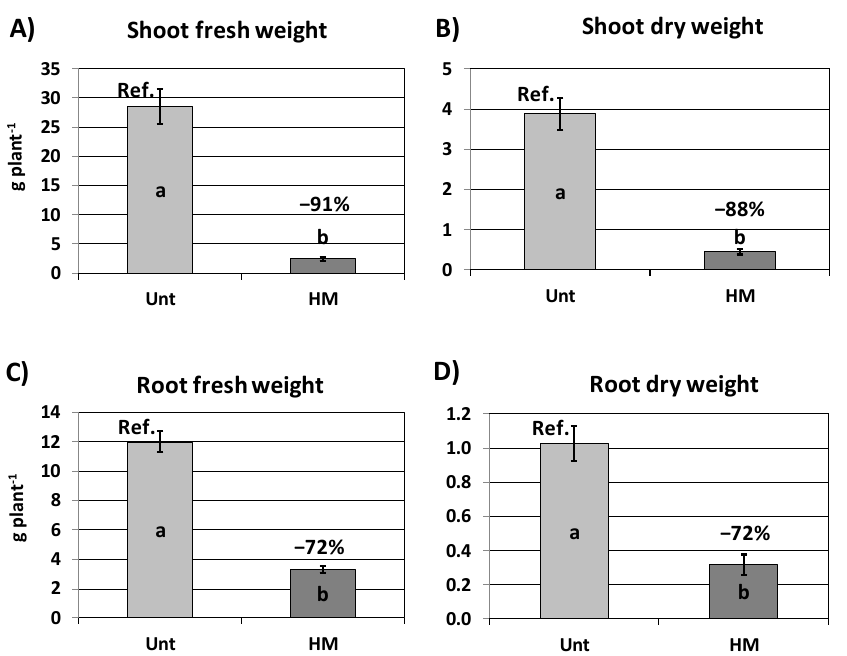
Figure 1. Shoot fresh ( A ) and dry ( B ) weight, and root fresh ( C ) and dry ( D ) weight (g plant − 1 ; ± SE; n = 4) of maize plants var. Naudi at the 3–4 leaf stage, after 41 days of cultivation in uncontaminated controls (Unt) vs. HM-contaminated soil. Numbers above the histograms refer to the % variations vs. Unt. Letters indicate significant differences between treatments in the same parameter (Newman–Keuls test, p ≤ 0.05).